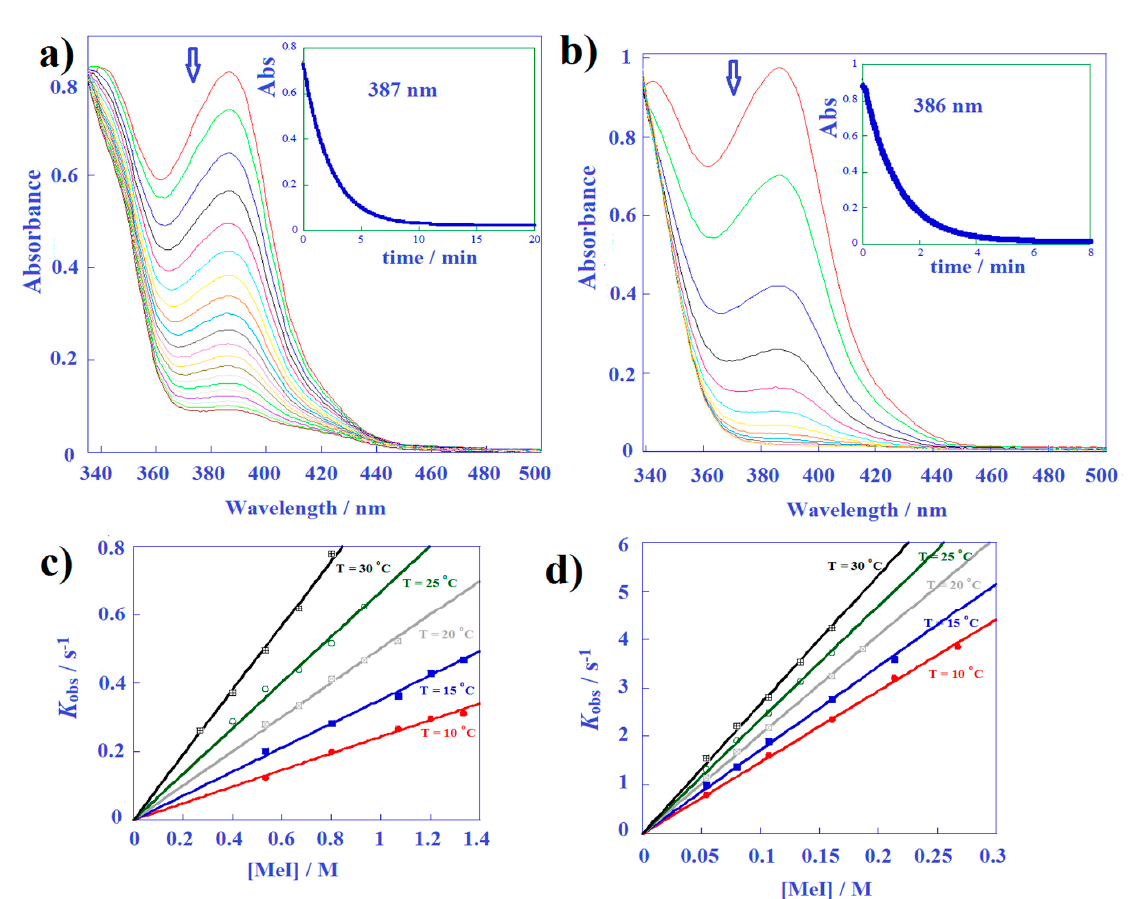
Figure 4. The changes in the UV-visible spectra of ( a ) 1a and ( b ) 1c with MeI in acetone at 25 °C (inset is the variation of absorbance at a corresponding wavelength over time). Plots of the first-order rate constants ( k obs /s –1 ) for the reactions of ( c ) 1a and ( d ) 1c with MeI in acetone at different temperature conditions versus MeI concentration. Table 3. Second-order rate constants a and activation parameters b for the reaction of 1 with MeI in acetone c . Complex